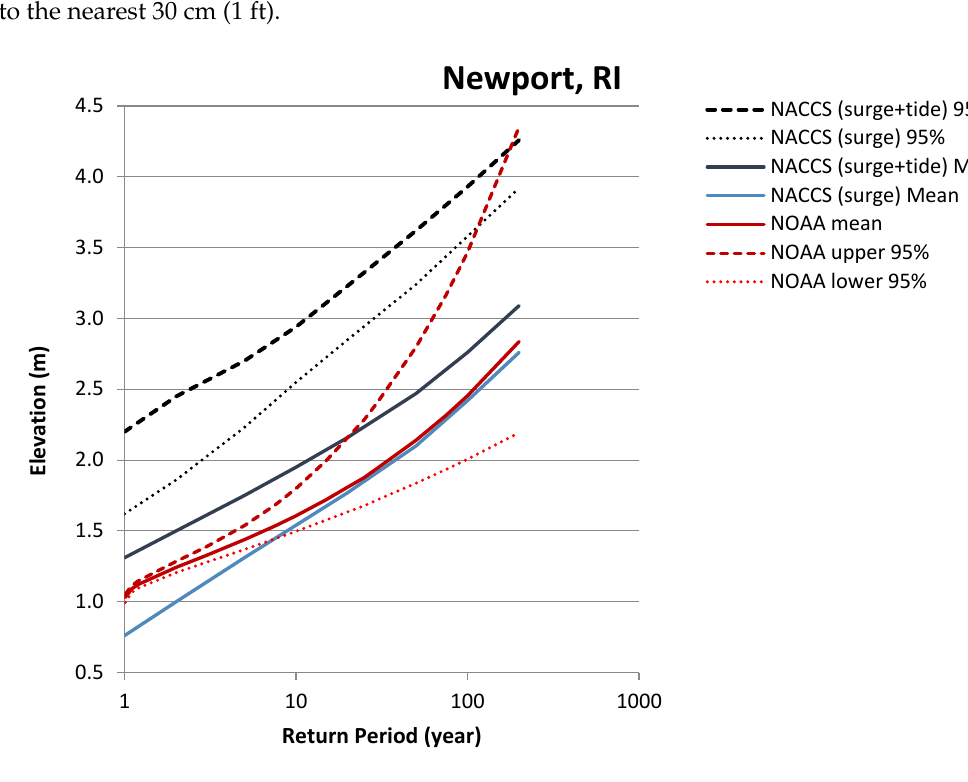
Figure 8. Surge elevation (meters, relative to NAVD88) vs. return period (years) for Newport, RI (Station ID #8452660). Estimates are provided from NOAA for the mean and lower and upper 95% confidence intervals and for NACCS for mean and upper 95% confidence intervals, for the surge only and surge plus tidal cases.